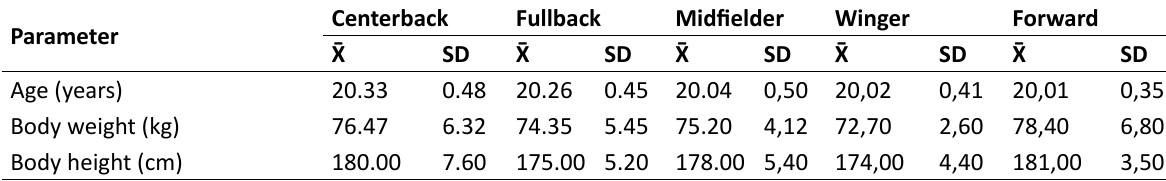
Table 1. The descriptive statistics of age, body weight and height of young soccer players Centerback Parameter